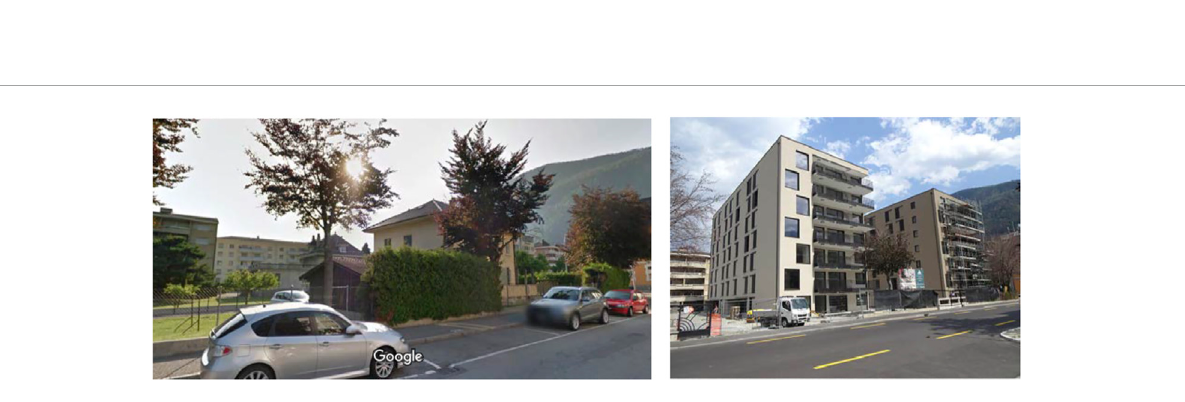
FIGURE 13 Martigny,twolow-riseURMbuildingsdemolishedandreplacedbyagroupofthreeidentical.mid-riseRCbuildings(onlytwoofthemarevisible on the right picture).